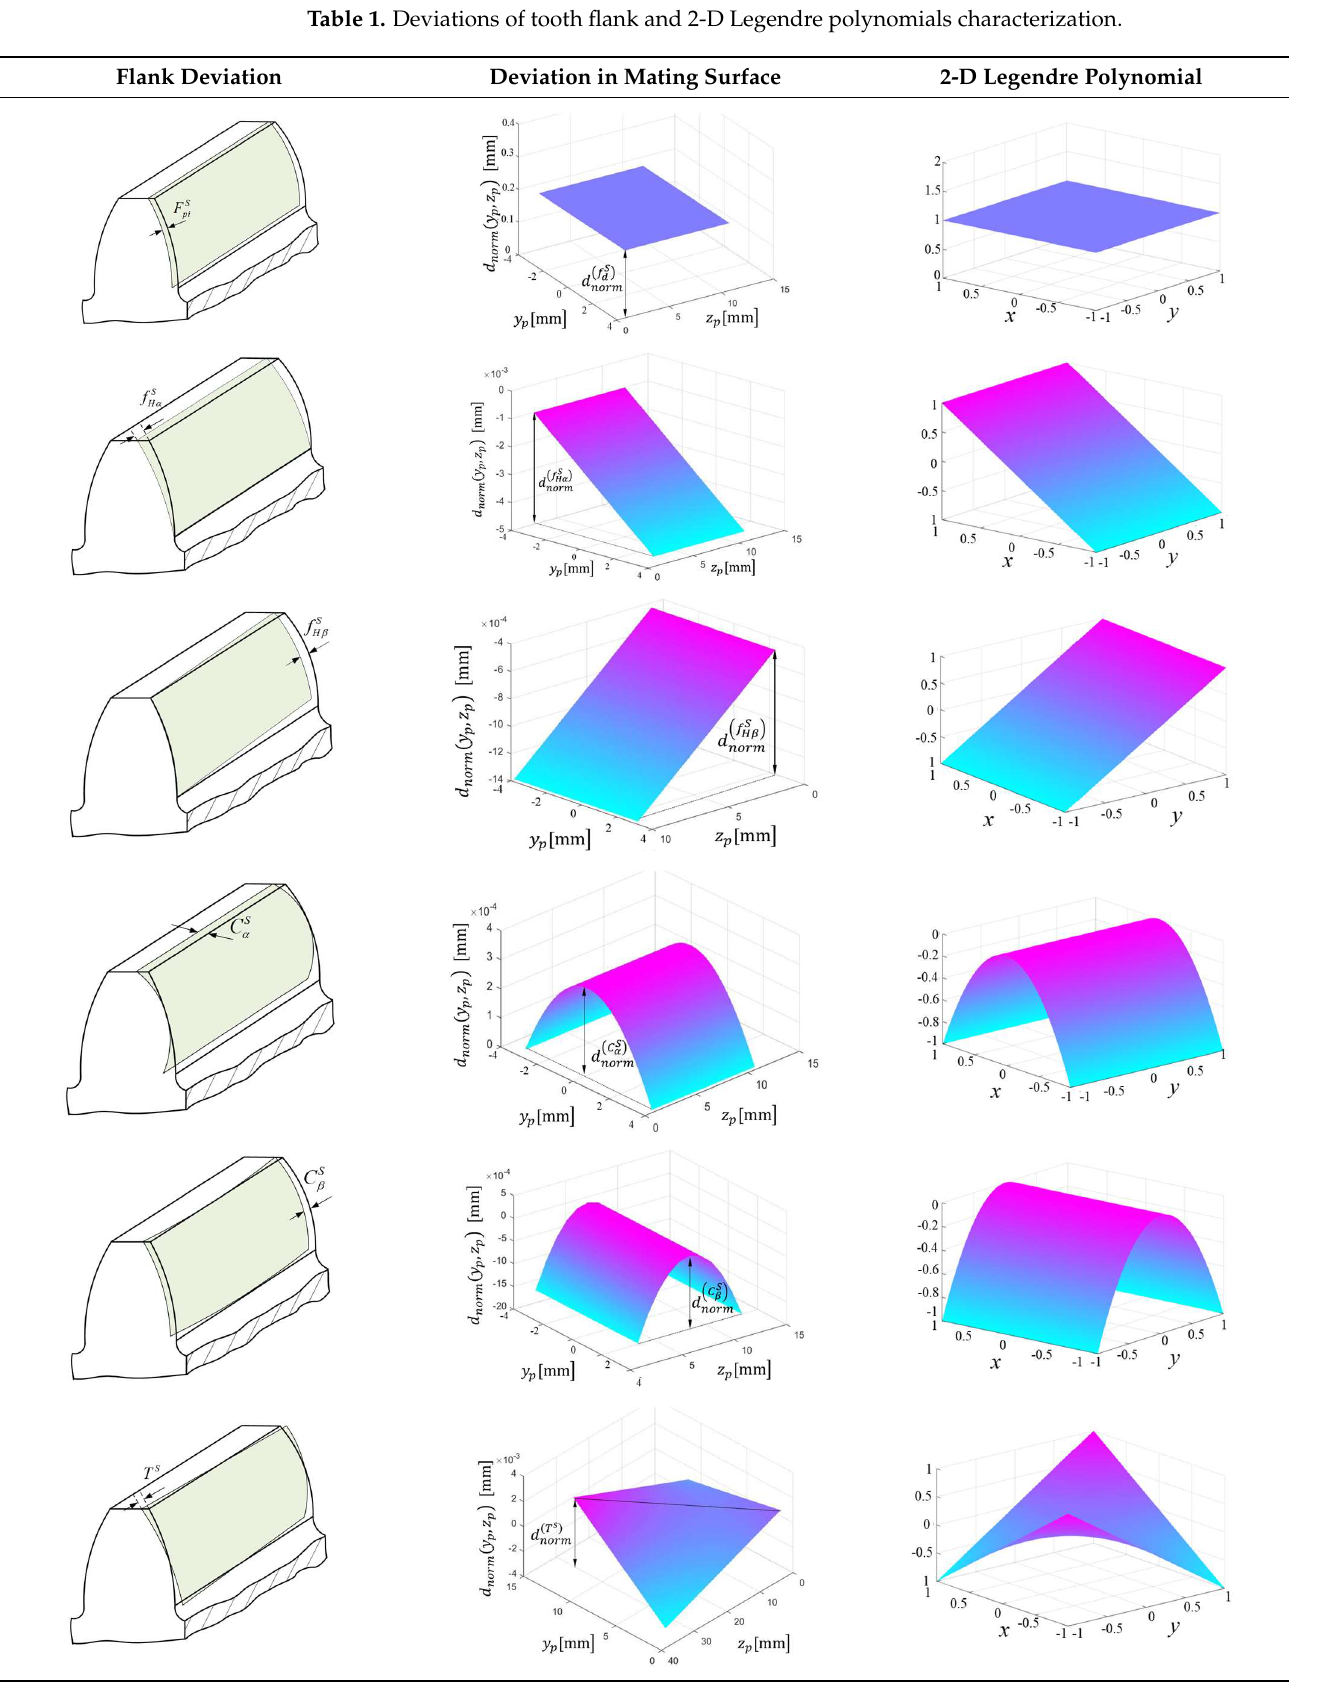
Table 2. Relationship between expansion coefficients and typical deviations of tooth flank.